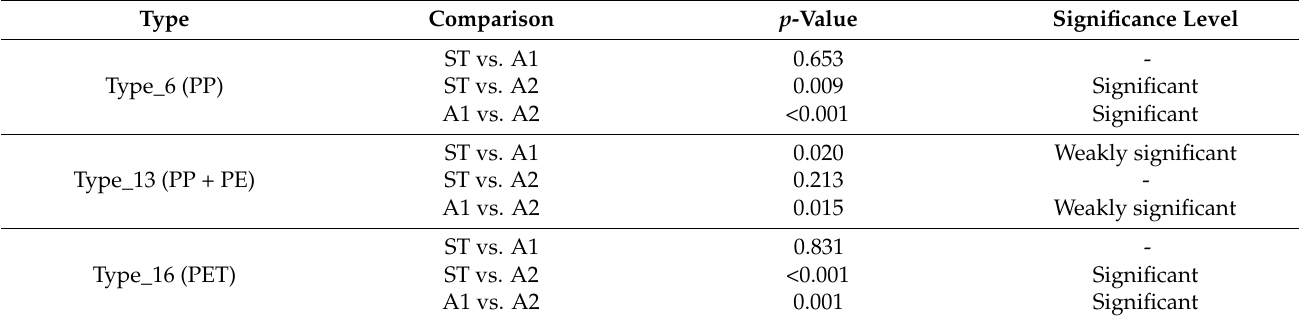
Table 5. Effect of water acidification in P. lividus ecotoxicological responses (100% of leachate dilution). T-test was performed within each plastic type comparing the different scenarios of acidification (ST vs. A1; ST vs. A2; and A1 vs. A2). “Weakly significant” corresponds to 0.05 < p -value < 0.01 and “Significant” to p -value <